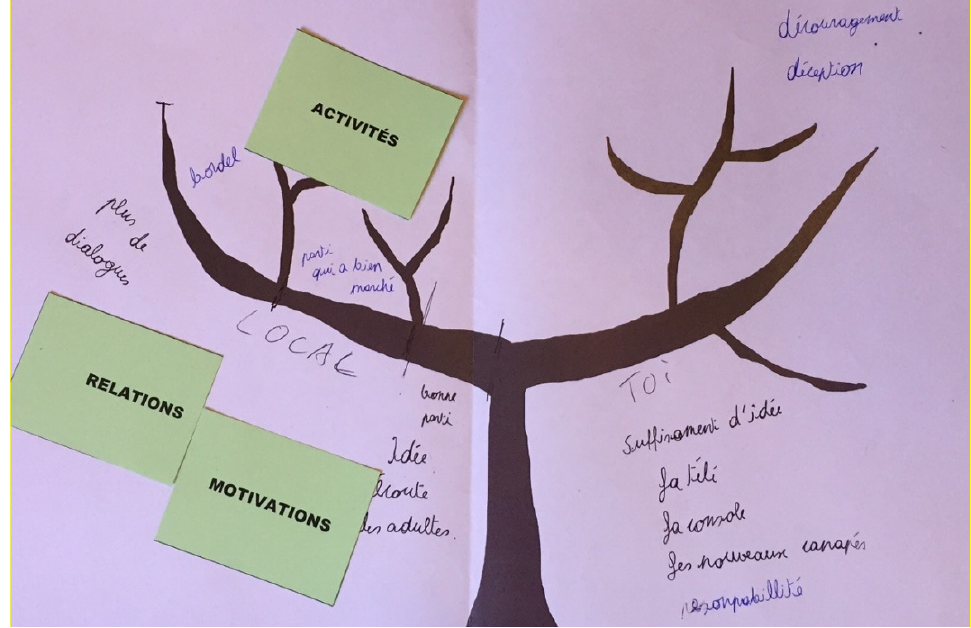
Figure 4. Mind mapping tree for M in C3.